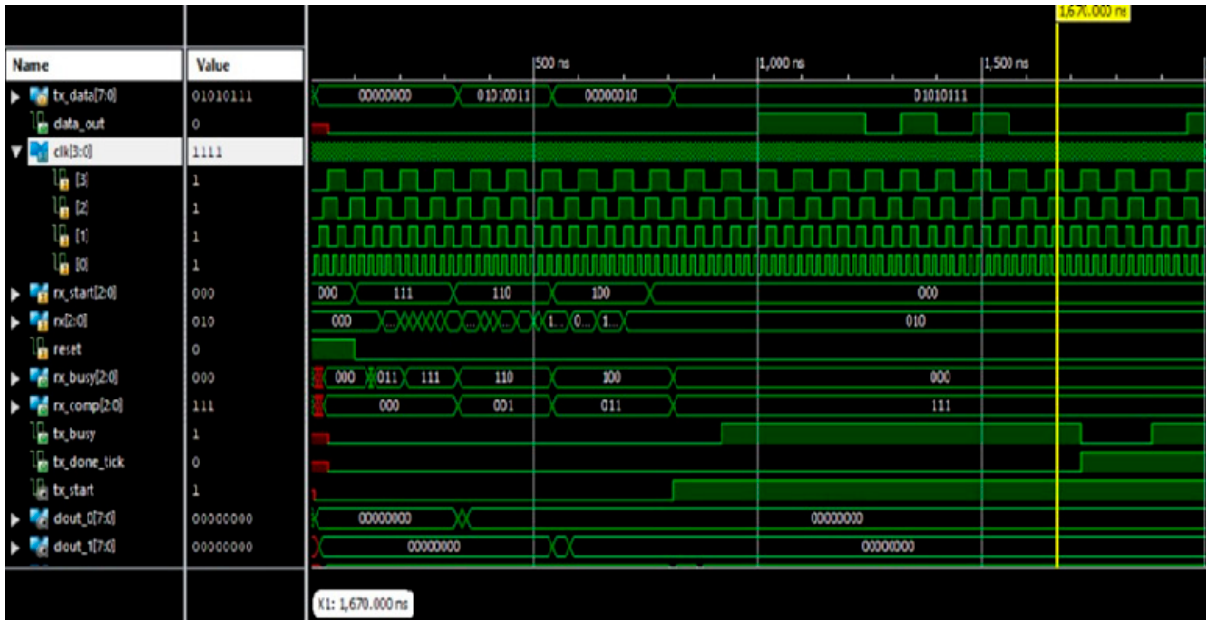
Figure 9. Verilog behavioral simulation.